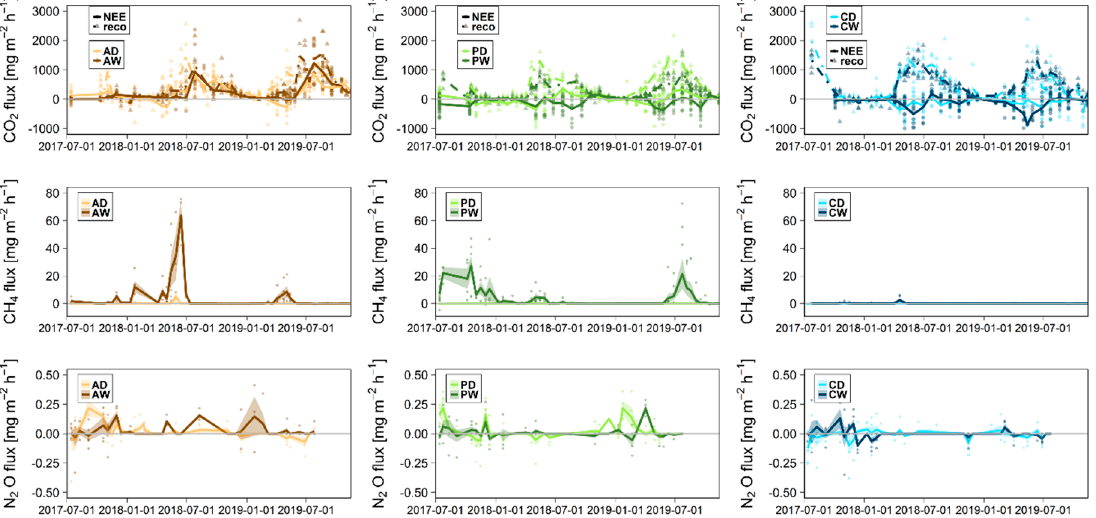
Figure 9. Greenhouse gas exchange on all study sites over the course of the studied period; with dots showing measured fluxes, lines showing average fluxes and shaded area showing the standard deviation of fluxes at the measurement campaigns. Negative values represent uptake. Study sites are color coded (see legends). Top = CO 2 exchange; dashed lines show RECO and solid lines show GPP. Middle = CH 4 exchange. Bottom: N 2 O exchange. Please note the strongly varying y -axis scalings among gases.